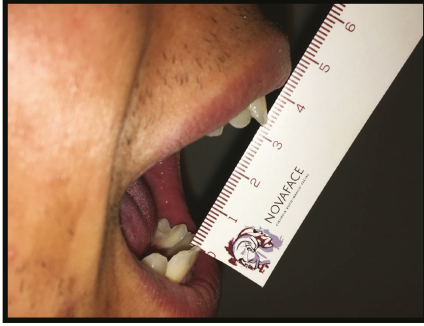
Figure 17: Picture emphasizing the mouth opening of 32 mm after two years of postsurgery.